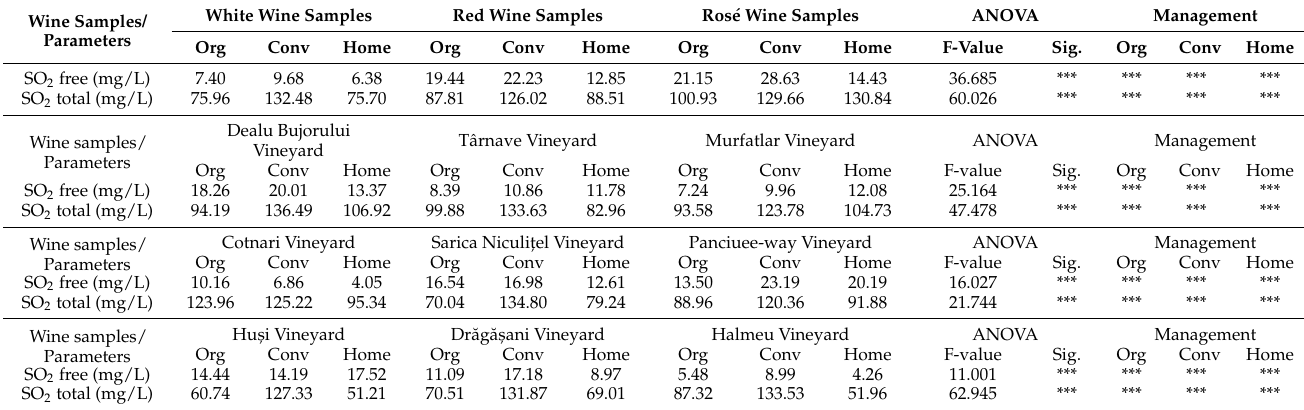
Table 2. The ANOVA, which presents the separation of mean SO 2 (free and total) concentration from organic, conventional, and homemade wine